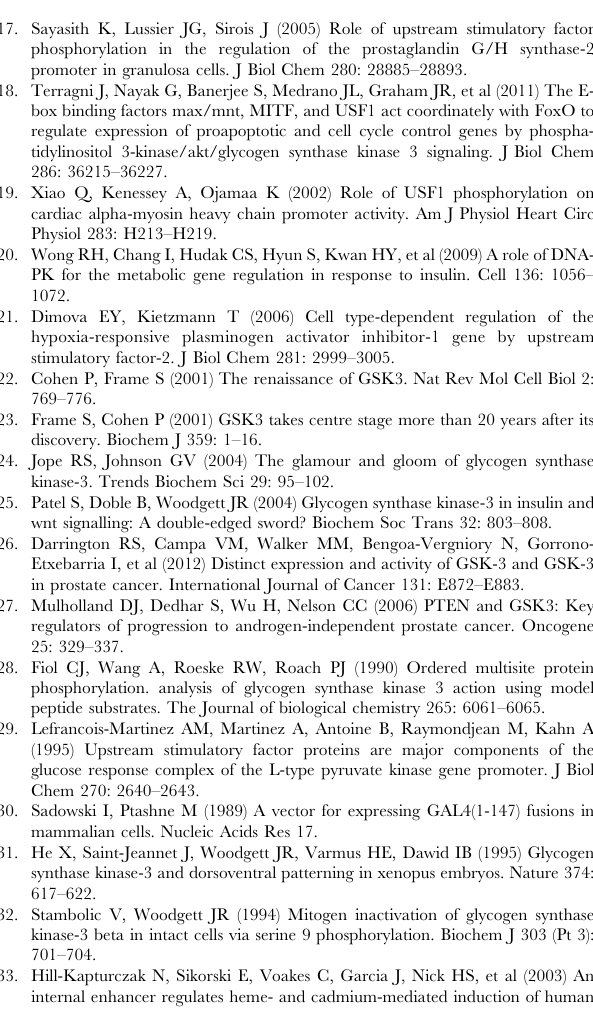
Figure 7. The phosphorylation of USF2 by GSK3 b affects cell migration. (A, B, C, D) GSK3 b 2 / 2 cells were transfected with vectors allowing expression of USF2-S155A/T230A or USF2-S155D/T230D or an empty vector. Cellular viability, proliferation and cell migration were monitored by MTT, BrdU (A) and cell migration (B, C) assays. (B) Photographs from a representative Transwell chamber experiment. (C) Data represent the absorbance of crystal violet at 595 nm relative to the control. *, significant difference between GSK3 b 2 / 2 cells and GSK3 b 2 / 2 cells + USF2-S155D/T230D. (D) The expression of USF2 was controlled by Western blotting. 50 m g of protein from transfected cells were probed with an antibody against USF2 and a -tubulin.